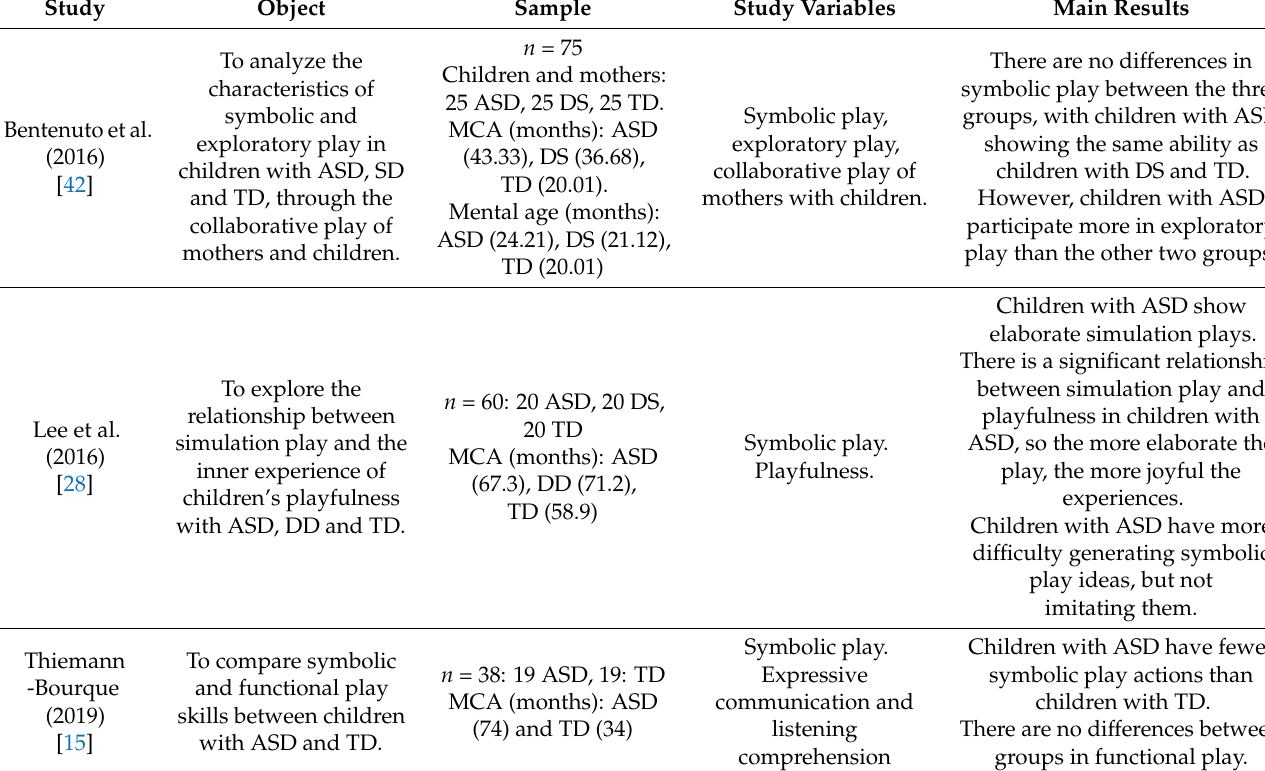
Symbolic play. Children with ASD have fewer Expressive symbolic play actions than communication and children with TD. There are no differences between listening groups in functional comprehension